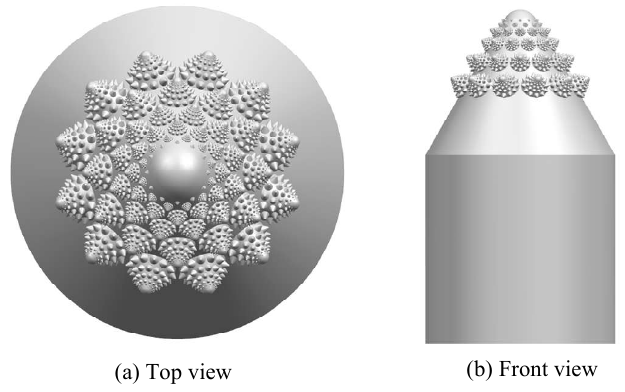
Figure 6. Biomimetic valve